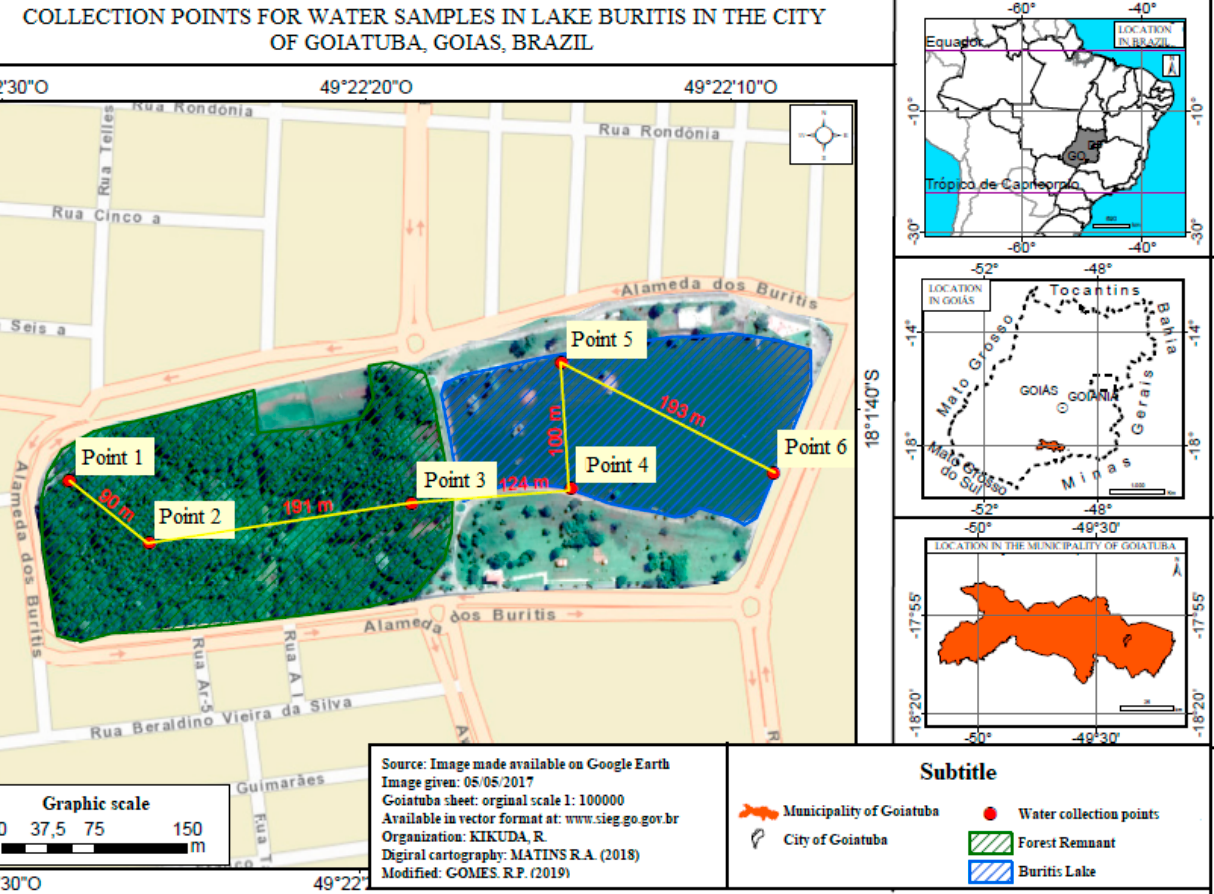
Figure 1. Sampling point location map of waters in and near Buritis